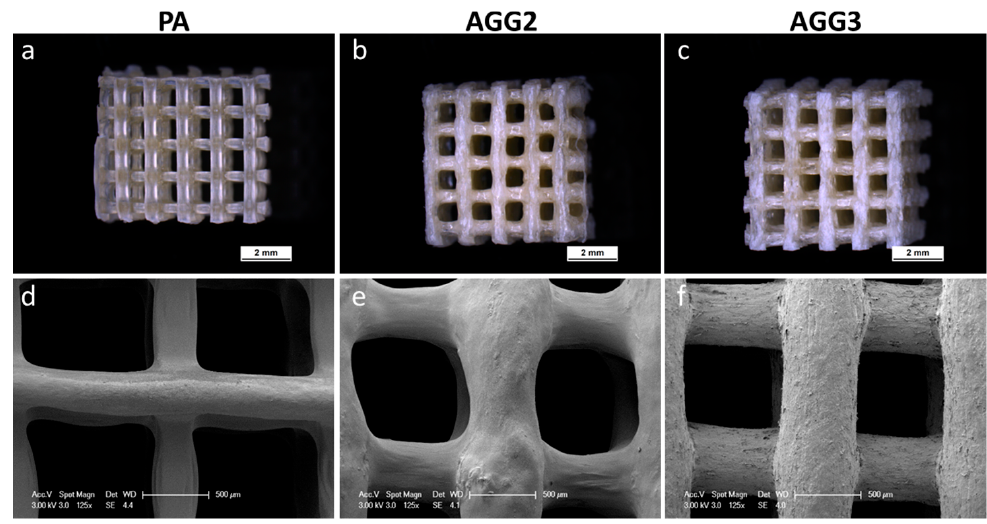
Figure 2. Light microscopic images of plotted scaffolds (25 layers) after freeze drying ( a – c )